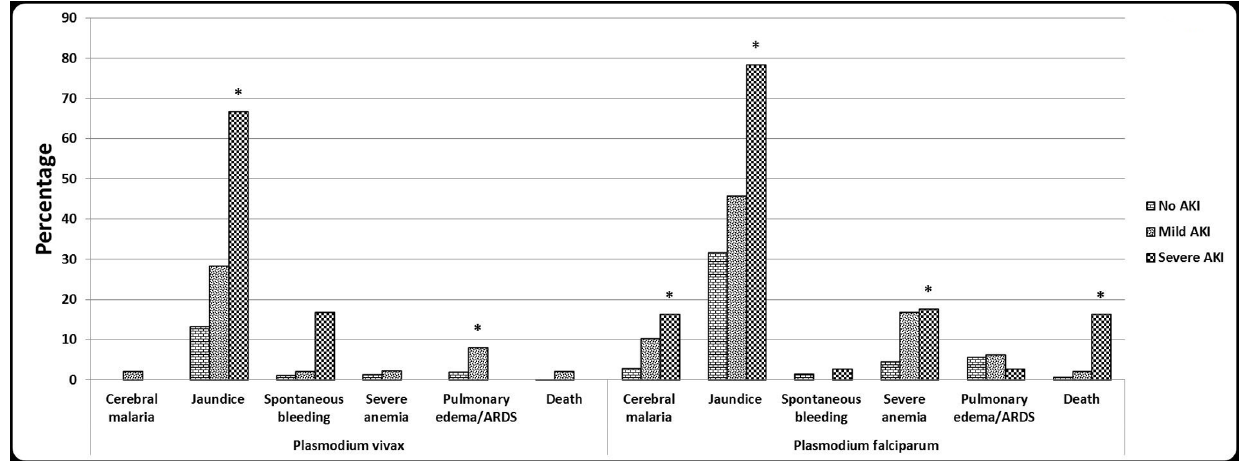
Figure 1. Association of AKI with complications by malaria species. *=P , 0.05 across AKI categories.